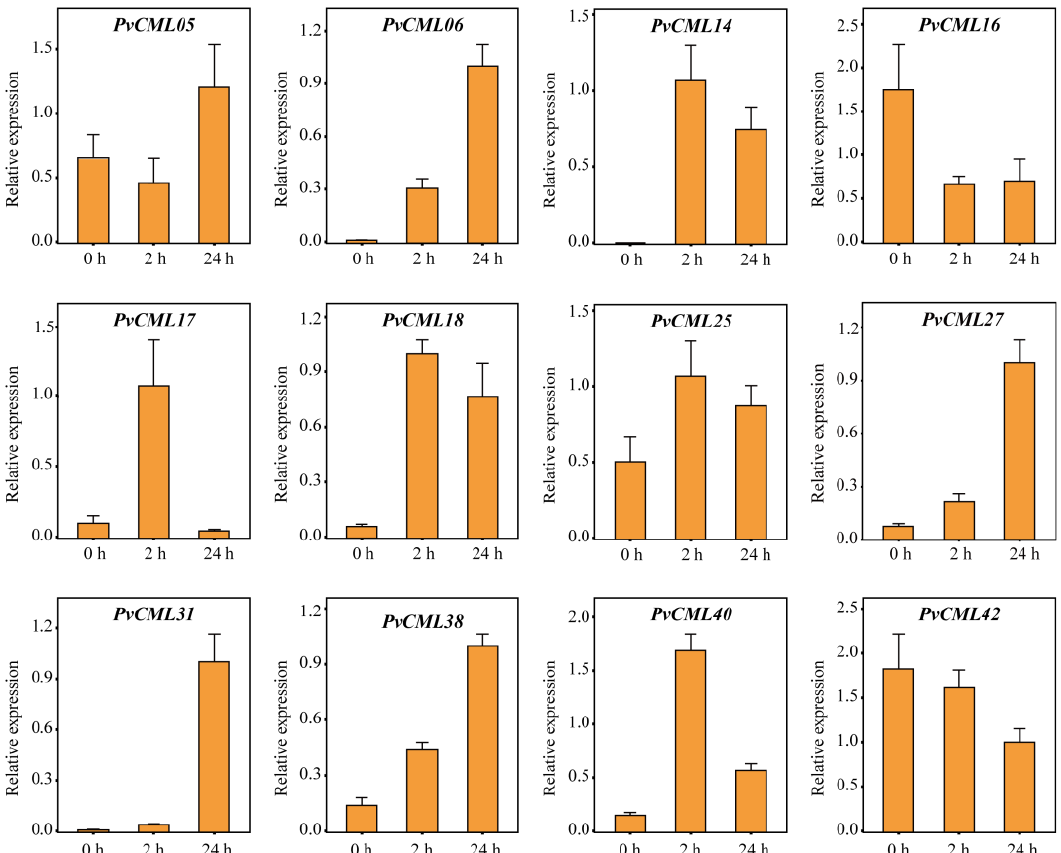
Figure 8. Gene expression analysis by RT – qPCR for the PvCMLs under cold stress conditions. The four-week-old seashore paspalum cultivars (sea spray) were treated with 4 °C, and three leaves were collected for each sample at 0 h, 2 h, and 24 h following treatment. Three biological replicates were performed for this analysis. The bar plot indicates the relative mRNA expression of each PvCML gene at each treatment time.